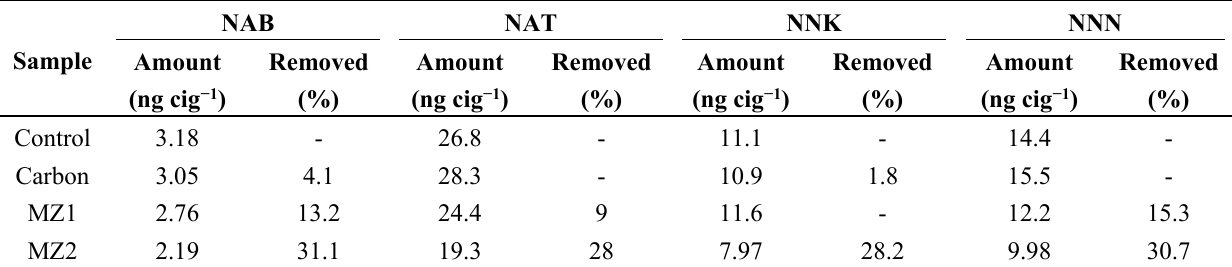
Table 4. The results of the porous materials as the filter additives to reduce the TSNAs in the mainstream